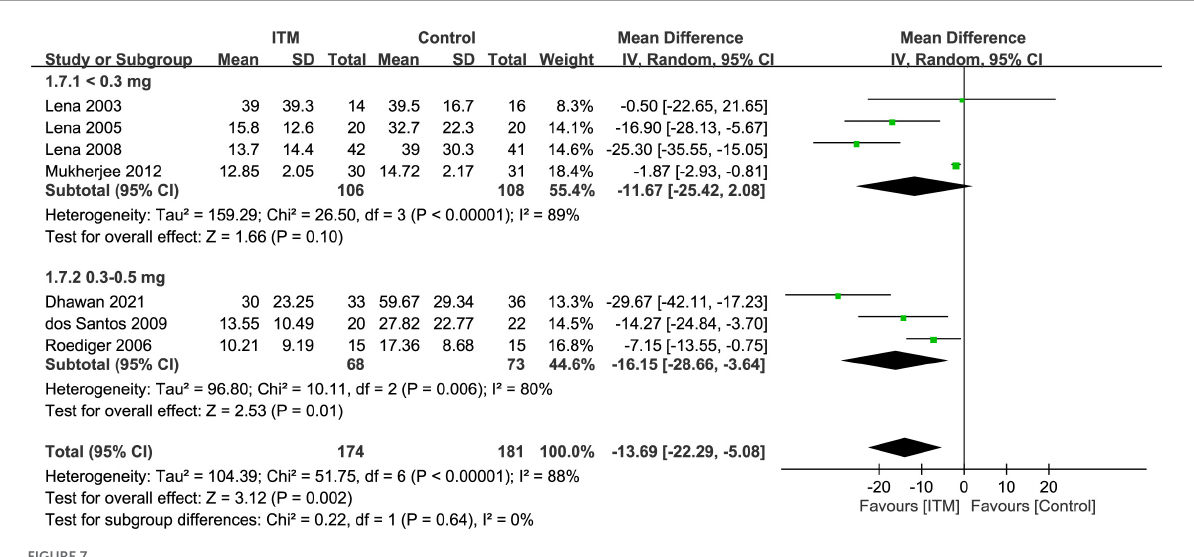
FIGURE7 Forest plot comparing intravenous morphine consumption at postoperative 24 h between intrathecal morphine (ITM) and control groups. CI, confidence interval; IV, inverse variance; SD, standard deviation.